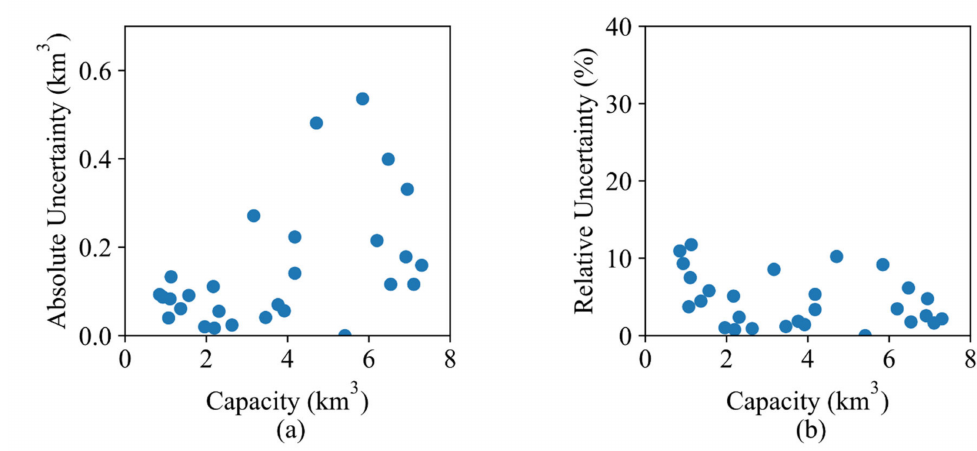
Figure 8. Uncertainty analysis results: ( a ) Absolute uncertainty; ( b ) relative uncertainty due to the unmeasured A - H relationship of SRTM